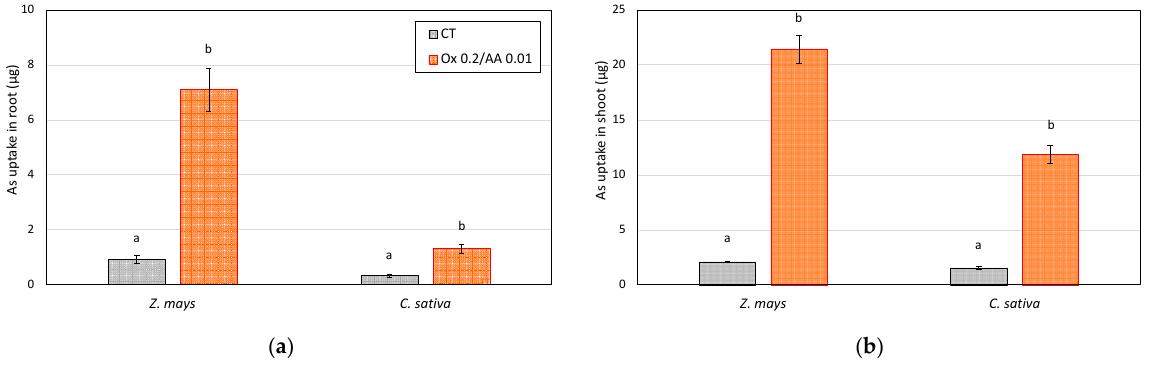
Figure 6. Arsenic uptake by ( a ) roots and ( b ) shoots of Z. mays and C. sativa grown on soil controls (CT) and soils treated with the 0.2 M oxalate and 0.01 M ascorbic acid solution (mesocosm tests). The values are the means of three replicates and the error bars show the standard deviations. Values with different letters are significantly different at the 5% probability level (Tukey’s